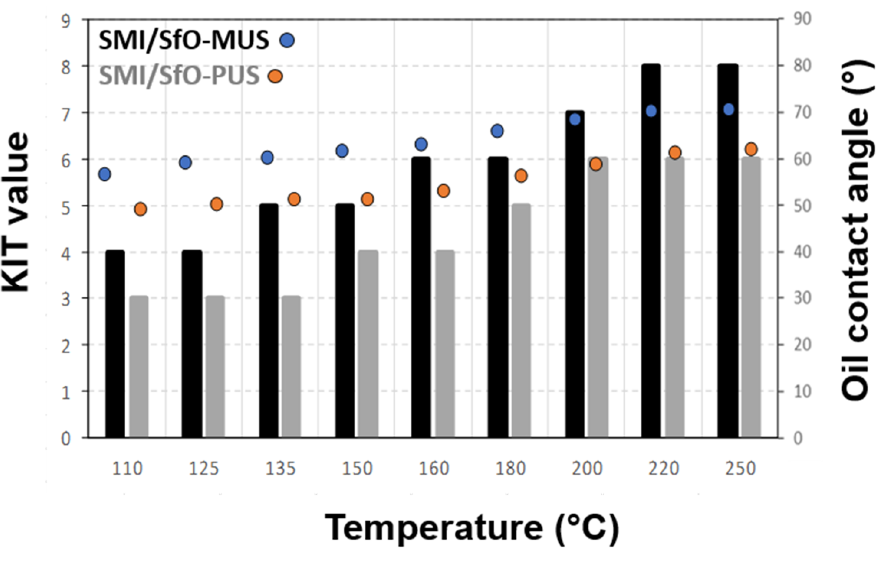
Figure 8. Oil resistance of SMI/SfO-PUS and SMI/SfO-MUS coatings on paper substrates as repre- Figure 8 sented by the KIT values (bars) and contact angles for castor oil